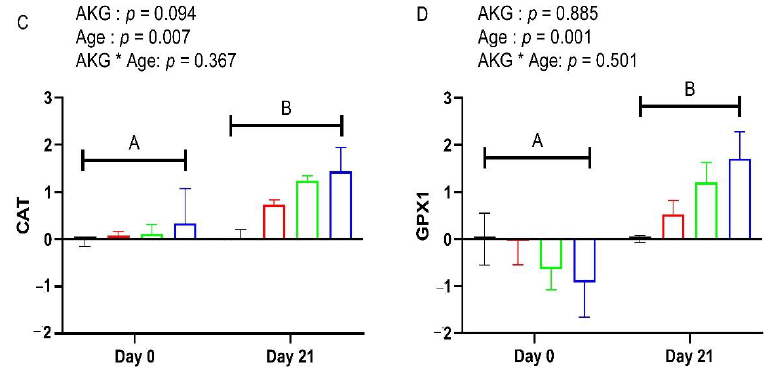
Figure 1. Effects of in ovo feeding of α -ketoglutaric acid (AKG) on hepatic mRNA expression of antioxidant-related genes NRF2 ( A ), SOD ( B ), CAT ( C ), GPX1 ( D ) at day 0 and day 21 of age in broilers. At 17.5 day of incubation, eggs were injected with 0.6 mL AKG solution with a concentration of 0% (0 AKG), 0.5% (0.5 AKG), 1.0% (1.0 AKG), and 1.5% (1.5 AKG) prepared in DDW, the chicks were raised in the thermoneutral environment as per standard guidelines of rearing. Data show mean ± SEM (n = 6). Means were analyzed by two-way ANOVA and Tukey post hoc test. A, B: means bearing different letters indicate a statistical difference ( p < 0.05) at different ages of the broilers. a,b: means bearing different letters indicate a statistical difference ( p < 0.05). Abbreviations: NRF2, nuclear factor erythroid 2-related factor; SOD, superoxide dismutase; CAT, catalase; GPX1, glutathione peroxidase 1. The gene regulation data were clustered vertically into three groups based on the Euclidian distances (Figure 2). The first cluster, located in the middle of the map, was composed of sampled hatchlings that mostly received AKG administration in ovo. These individuals presented a particularly strong downregulation (blue color) of GPX1 gene ex- pression. The second cluster, which appears on the left side of the map, was much more heterogeneous and consisted of individuals exhibiting moderate regulation (light blue or bright red color) of all four antioxidant-related genes without particular distinction. Fi- nally, a third cluster was located on the right side of the map. This cluster was dominated by birds (day 21) hatched from the eggs that received in ovo feeding of AKG. The birds of